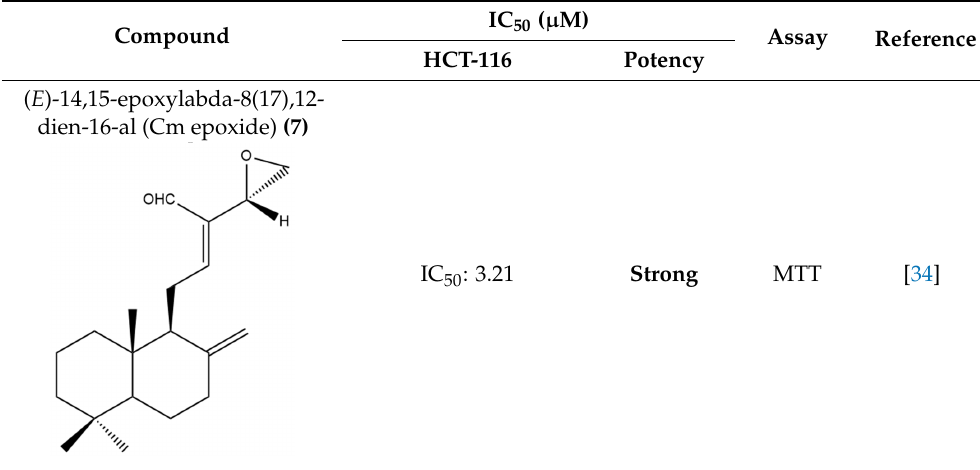
Table 13. Cytotoxic activities of labdane-type diterpenes from the Zingiberaceae against HCT-116 colorectal cancer cell